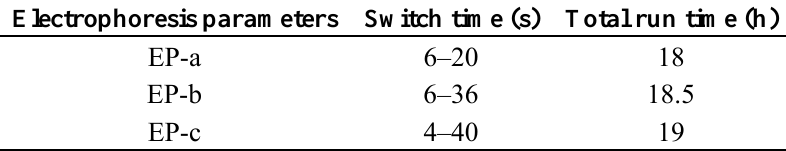
Table 1. Features of four electrophoretic parameters with Xba I